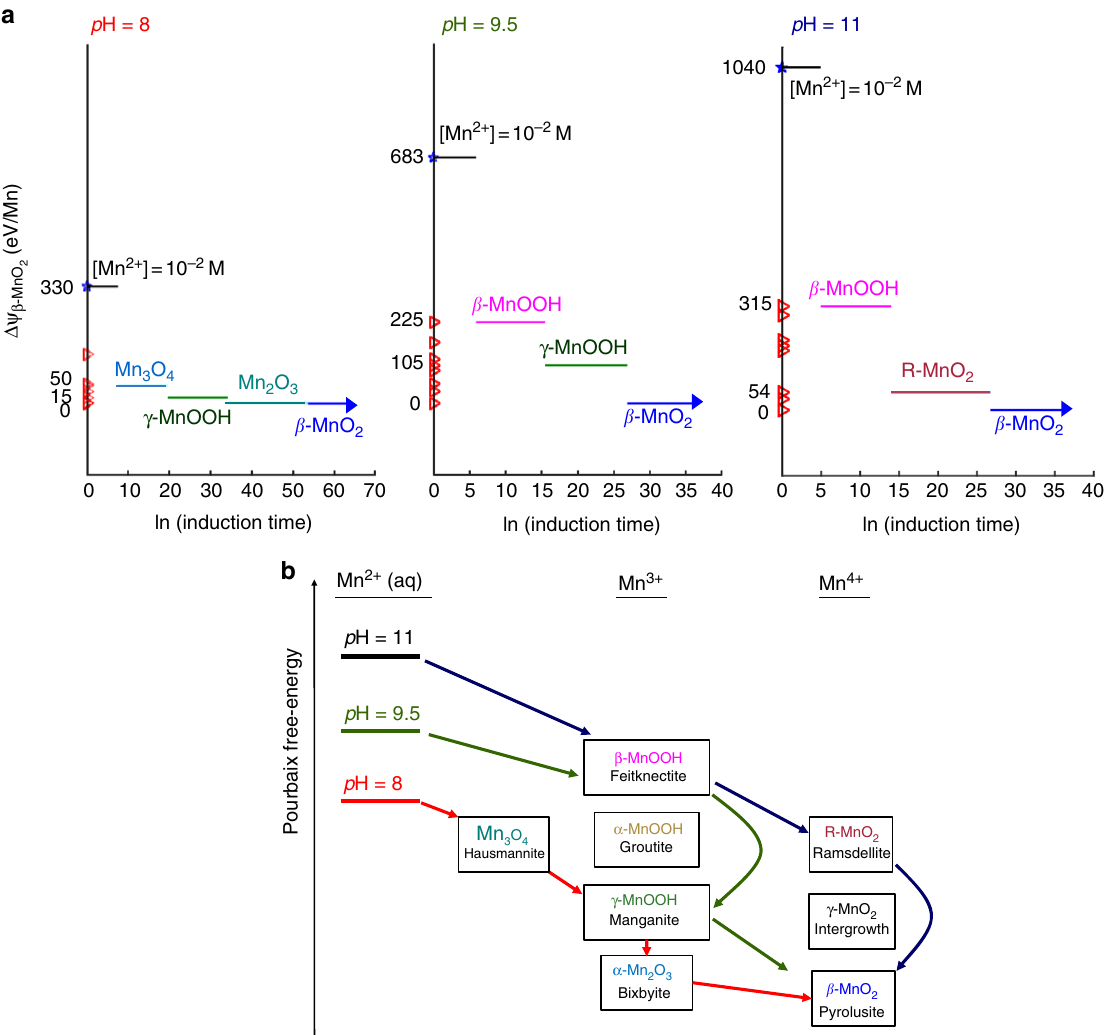
Fig. 4 Oxidation pathways of Mn 2 + (aq) at three pH conditions in the β -MnO2 stability region. a Induction time diagrams, with phases ordered vertically by the ΔΨ of a phase above β -MnO 2 . From the Mn 2 + precursor, the lowest-barrier phase nucleates and grows, persisting until the induction of the next more- stable phase. The process then repeats. b Schematic diagram of the three crystallization pathways as a cascade through the metastable energy landscape; energy axis not drawn to